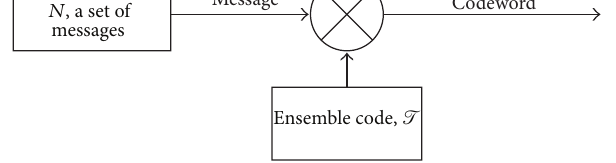
Figure 1: The Huffman coding concept.